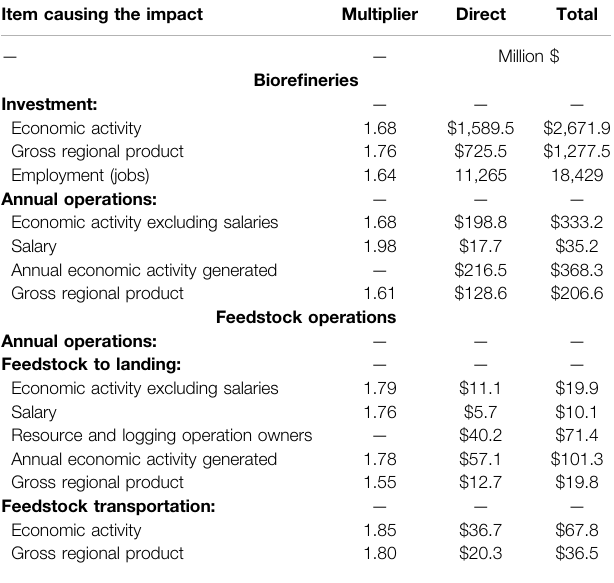
TABLE 12 | Economic activity generated by the three biore fi nery industry. Item causing the impact